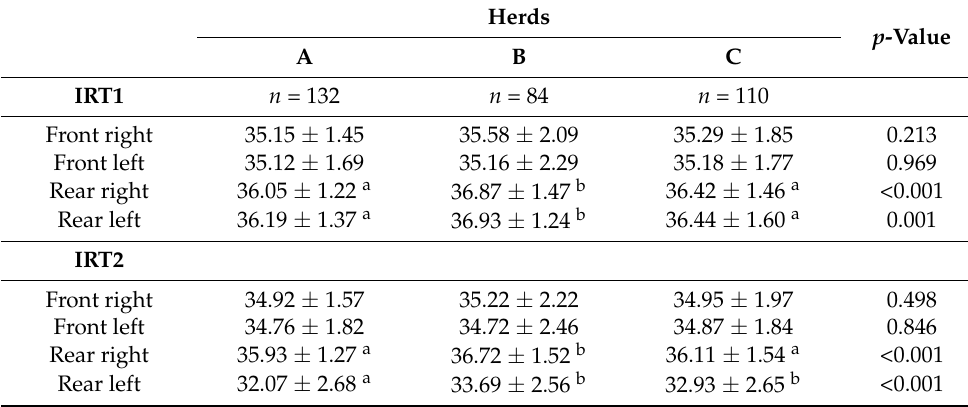
Table 2. Results of maximum temperature (mean ± SD) in each foot at four areas in replacement gilts of different genetic lines in three farrow-to-finish herds in Greece at first farrowing. Herds